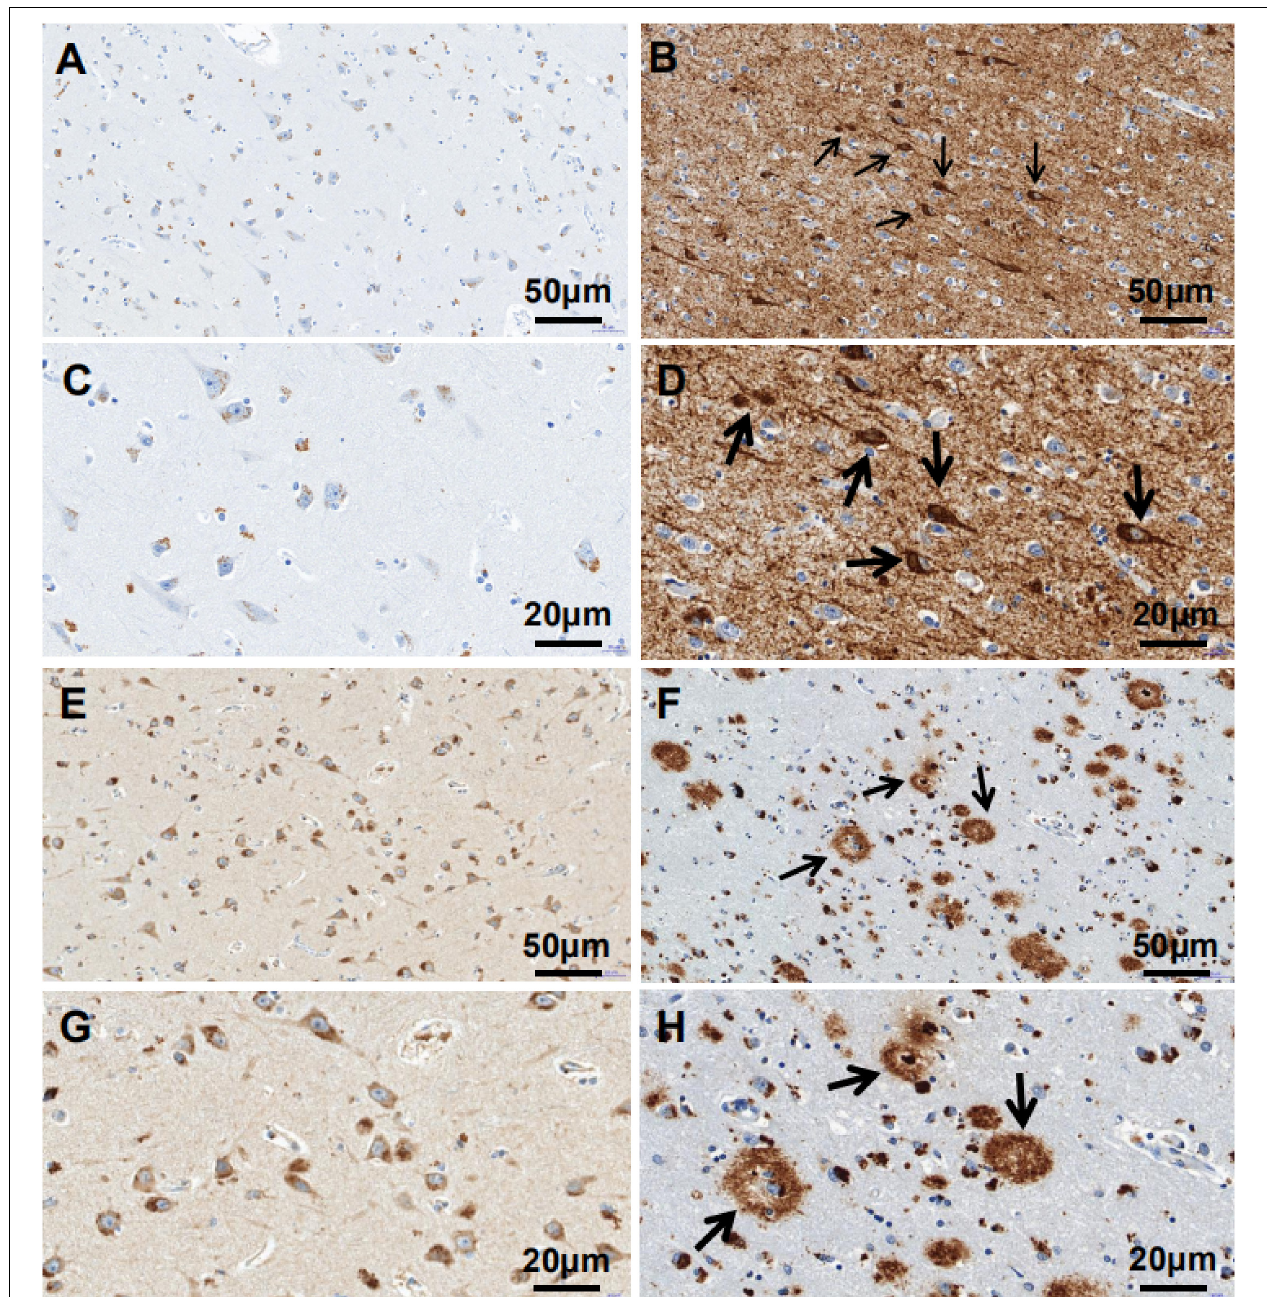
FIGURE 1 | p-tau and A β 17 - 24 expressions in the ITGC detected by immunohistochemistry. (A–H) p-tau and A β 17 - 24 immunoreactivity in control subjects (left) and AD patients (right). Patients with AD showed extensive accumulation of A β plaques [arrowheads in panels (F,H) ] and NFTs [arrowheads in panels (B,D) ] in the ITGC. Scale bar, 50 µ m (A,B,E,F) , 20 µ m (C,D,G,H) .